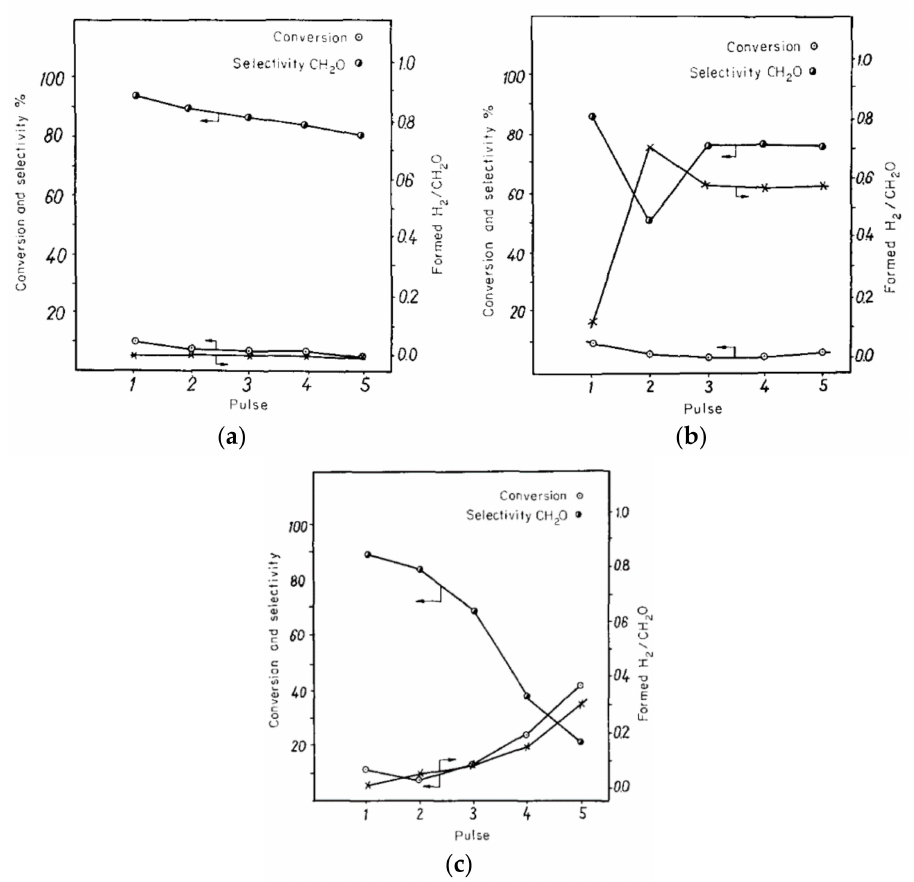
Figure 36. Overall conversion and selectivity in pulse reactions without O 2 at 340 ◦ C for ( a ) V/Ni = 1, ( b ) V/Fe = 1, and ( c ) V/Co = 1 [209]. Reproduced from [209] Copyright 1976, with permission from